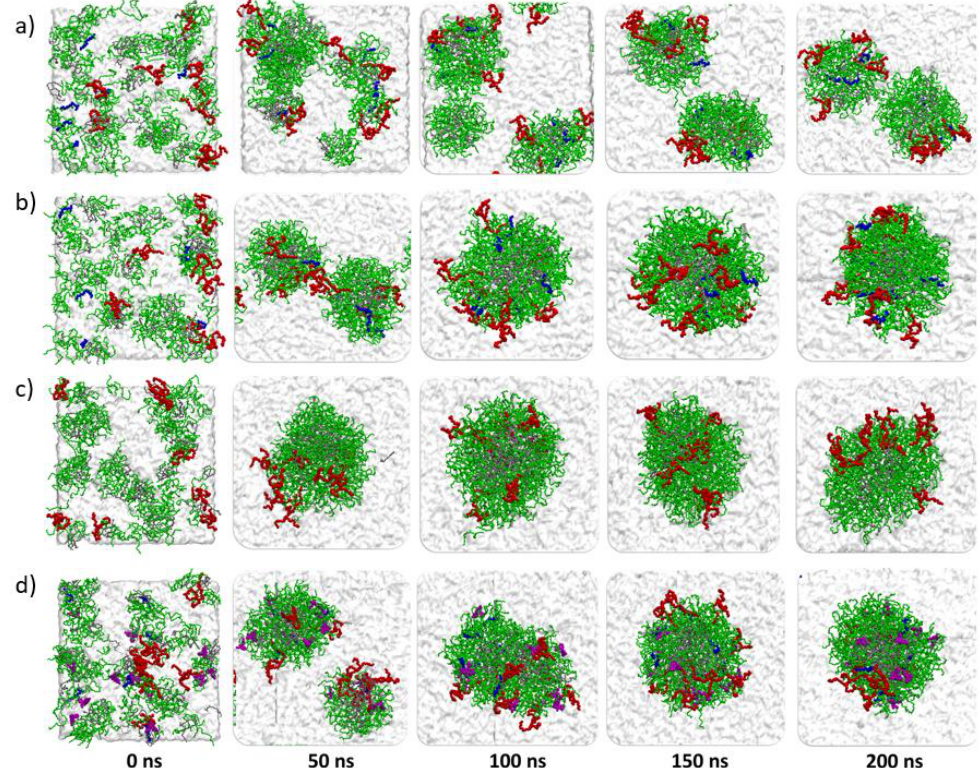
Figure 7. Trajectory snapshots of self-assembly process of ( a ) MD-1 (Miglyol ® 812, Tween ® 80 and Gelucire ® 44/14 at 300 K), ( b ) MD-2 (Miglyol ® 812, Tween ® 80 and Gelucire ® 44/14 at 358 K), ( c ) MD-3 (Tween ® 80 and Gelucire ® 44/14 at 358 K) and ( d ) MD-4 (Rhodamine 123, Miglyol ® 812, Tween ® 80 and Gelucire ® 44/14 at 358 K) in the aqueous medium at different simulation times. Color representations of Miglyol ® 812 (blue), Tween ® 80 (red), Gelucire ® 44/14 (green and gray) and Rhodamine 123 (purple).